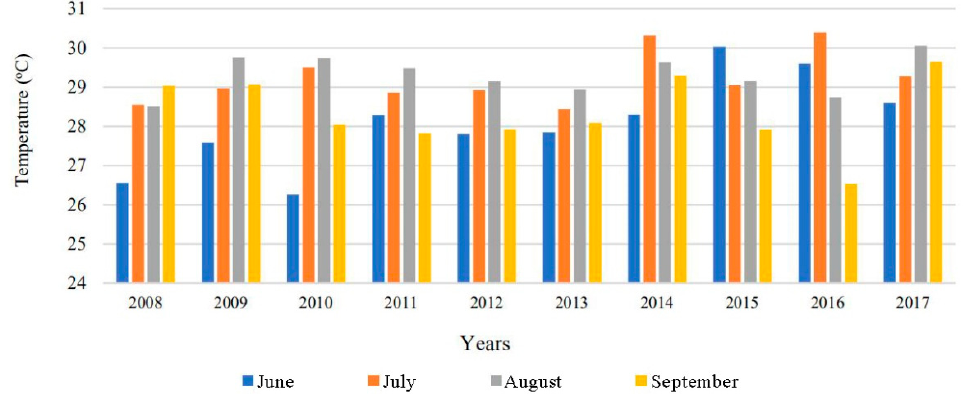
Figure 4. Meteorological statistics.